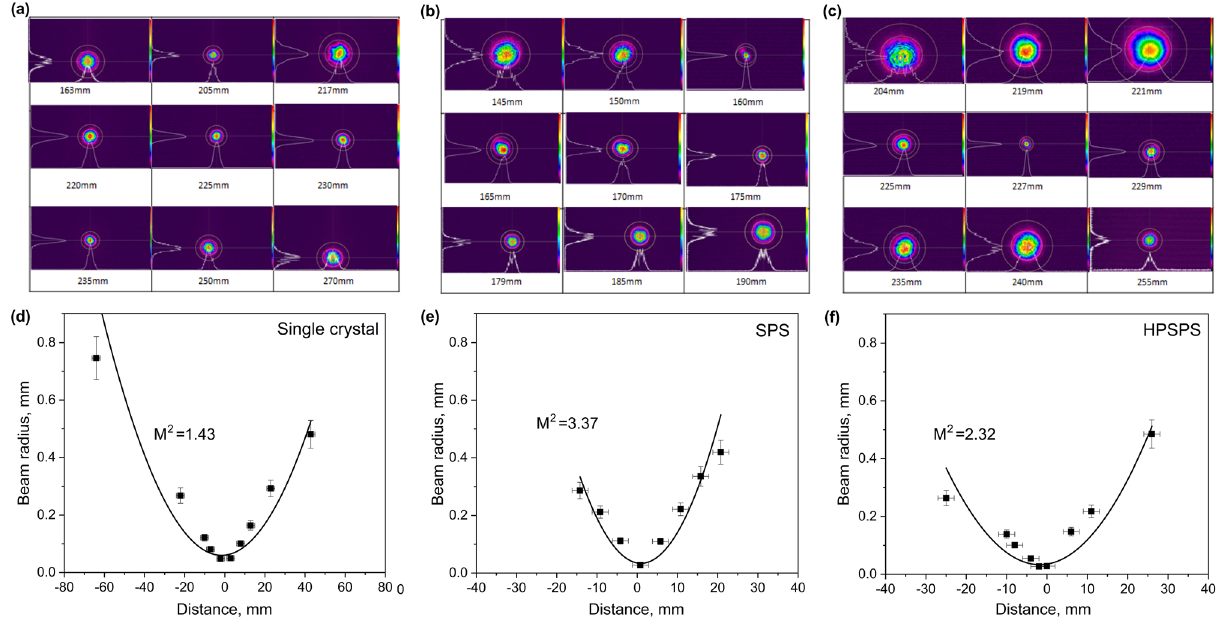
Figure 5. M 2 measurements: a series of images taken at different locations before and after the waist location for ( a ) the reference crystal, ( b ) an SPS-processed sample, and ( c ) a HPSPS-processed sample. Results of beam diameter versus distance, yielding different M 2 values for ( d ) the reference crystal, ( e ) an SPS-processed sample, and ( f ) a HPSPS-processed